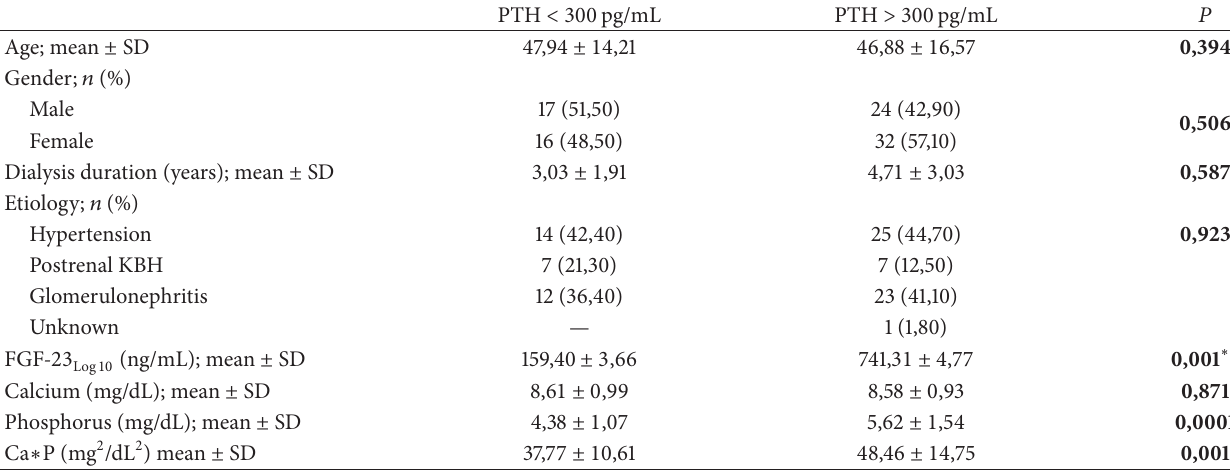
Table 1: The relationships of demographic features and comparison of serum parathormone levels with fibroblast growth factor-23, calcium, and phosphorus in the dialysis patients.